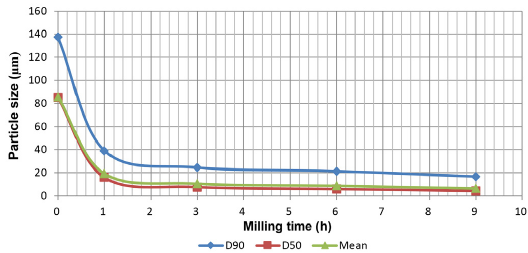
Figure 2. Particle diameter of powders at different milling times.